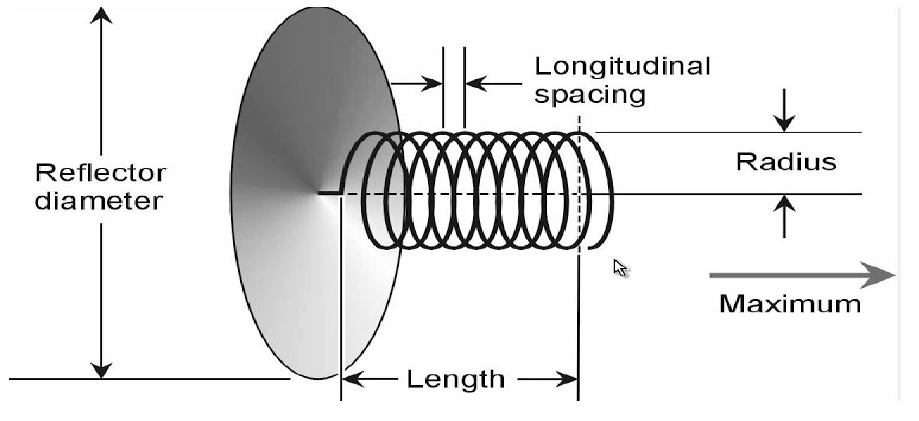
Figure 6. Helical antenna [59].